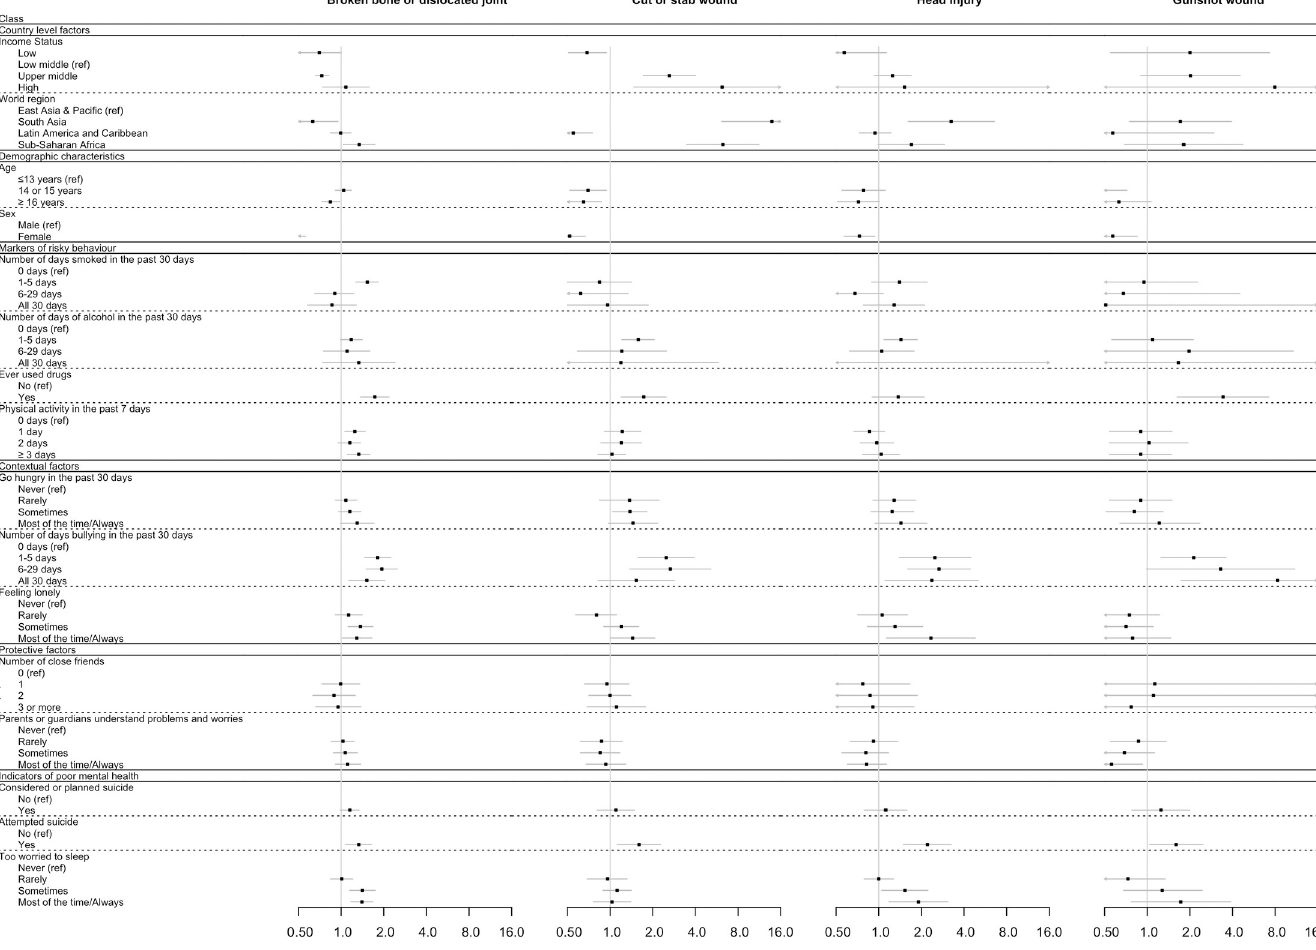
Fig 2. Forest plot showing the multivariable association (as odds ratio [OR] and 95% confidence interval [95% CI]) between serious injury type (broken bone or dislocated joint, cut or stab wound, head injury, and gunshot wound) and markers of psychosocial circumstances, adjusting for country-level factors and demographic characteristics, but not for aggressive behaviour indicators. Adjustment for non-response rate of participants was done as described in Methods. p- Values can be found in Table 5. � Head Injury refers to the variable ‘concussion or other head or neck injury, was knocked out, or could not breathe’.